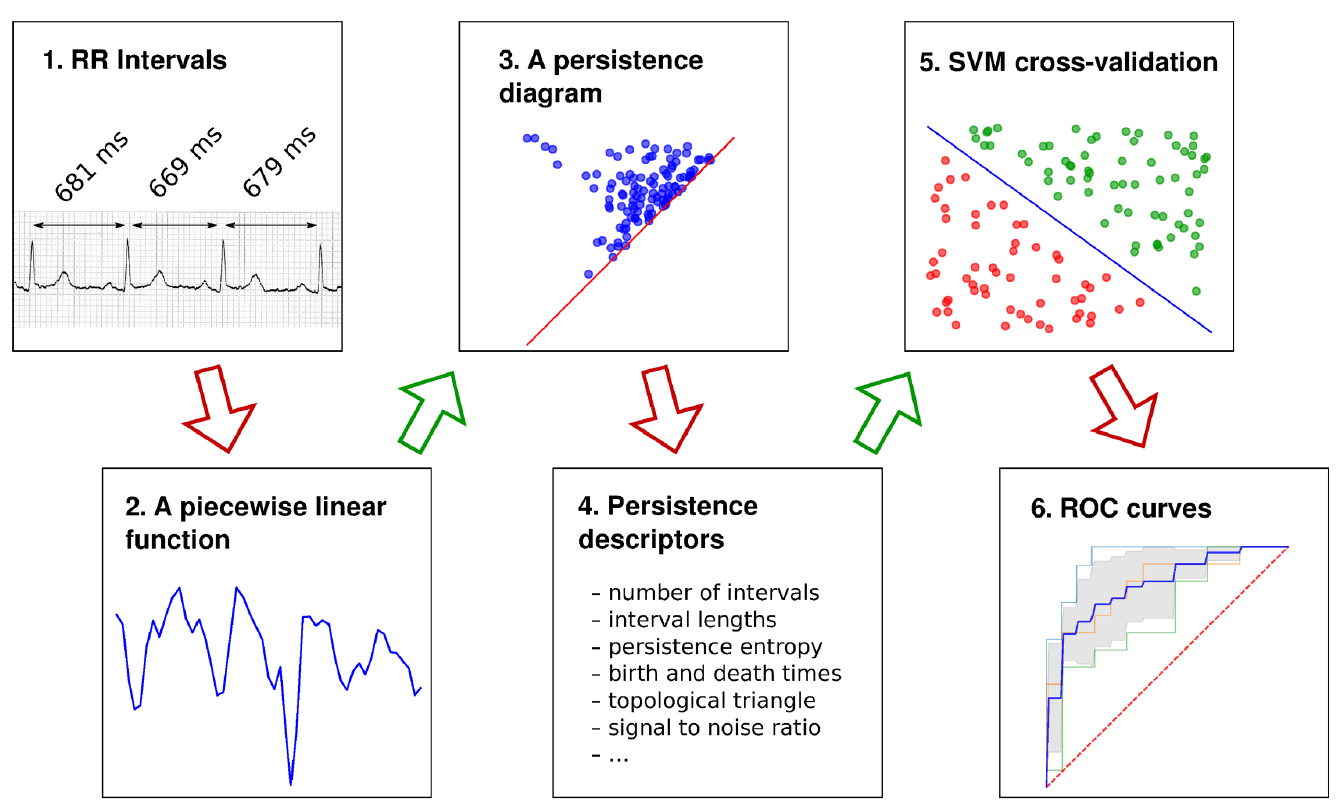
Fig 3. The steps 1–6 of data analysis described in Section